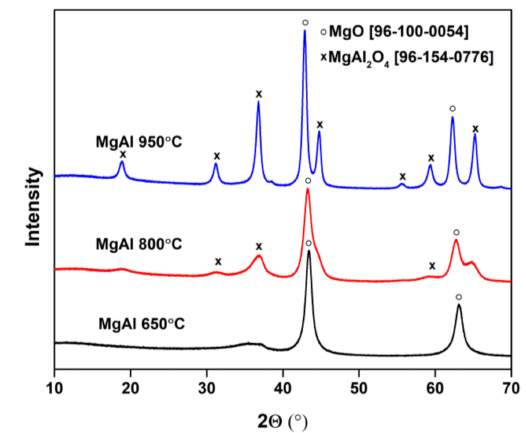
Figure 1. XRD patterns of mixed metal oxides (MMO) obtained by heating the Mg 2 / Al 1 precursor gels at 650 ◦ C, 800 ◦ C, and 950 ◦